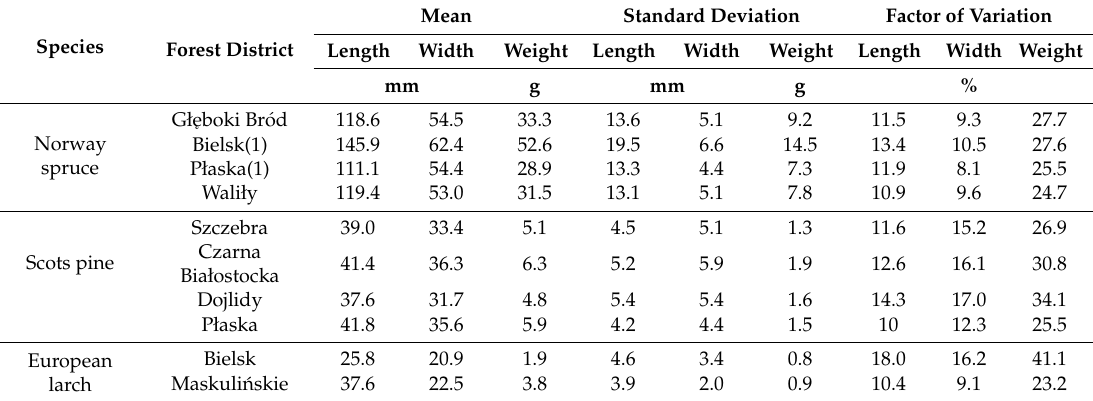
Table 2. Means, standard deviations, and factors of variation for the dimensions and weight of the studied